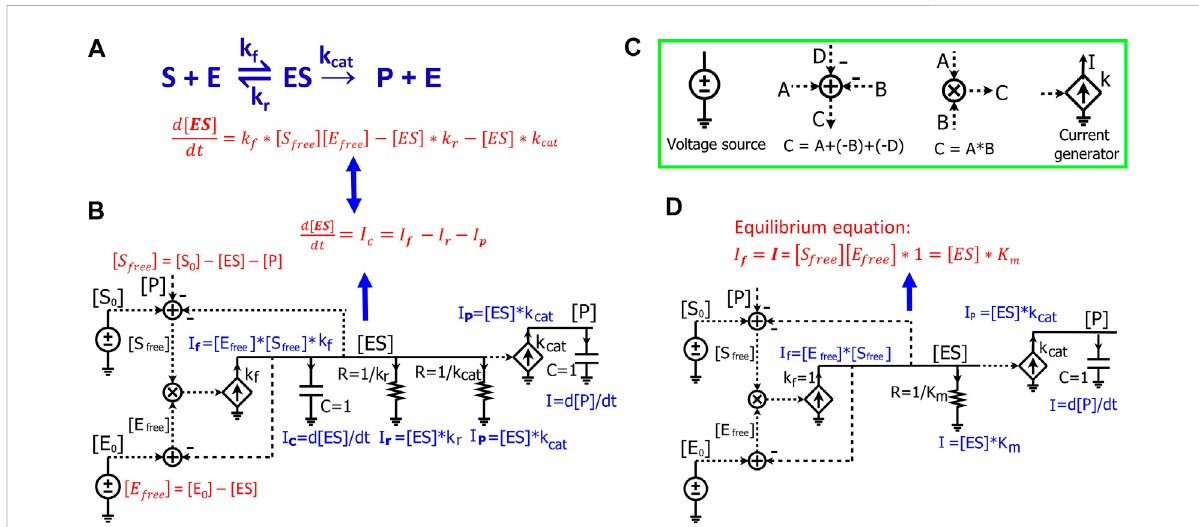
FIGURE 3 Modeling Michaelis-Mentenkineticsofenzymaticreactionsbysimpleelectroniccircuits. (A) Ageneralenzymaticreactionwhereintheenzyme EbindstothesubstrateS,forminganenzyme-substratecomplexES,whichconvertsStoaproductP. (B) Theelectroniccircuitexactlydescribesthe kinetics of the enzymatic reaction in (A) . All the math equations describing the voltages and/or currents of the circuit are indicated near the corresponding nodes. The dashed lines are wires connecting the same voltage between two nodes/components in the circuit and have no current running through them. The voltages labeled with the same names indicate that they have the same values. The voltages are mainly for math calculationssuchascalculatingthemassconservationofareagentviatheadder/subtracterblocks,ormultiplyingtwoconcentrationsviaamultiplier block. They are also used as inputs to voltage-dependent current generators (transconductors, the diamond symbols) to control their output currents. (C) Electronic symbols used in the circuits in addition to the symbols from Figure 1. (D) The Michaelis-Menten circuit of (A) , but with a steady-state approximation such that the [ES] capacitor is removed. Since the capacitor has been removed, resistors are directly related to steady- state Michaelis-Menten constants onlyanddo notaffect dynamic parameters liketime constants. Inthiscase, theresistor R= 1 /K m ( Ω )andK m arein the standard molar concentration unit,